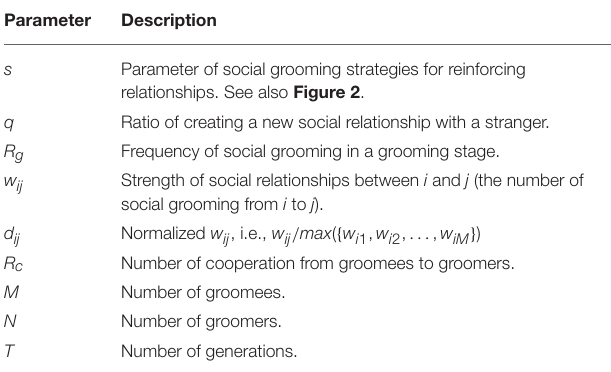
TABLE 1 | Descriptions of model parameters. Parameter Description